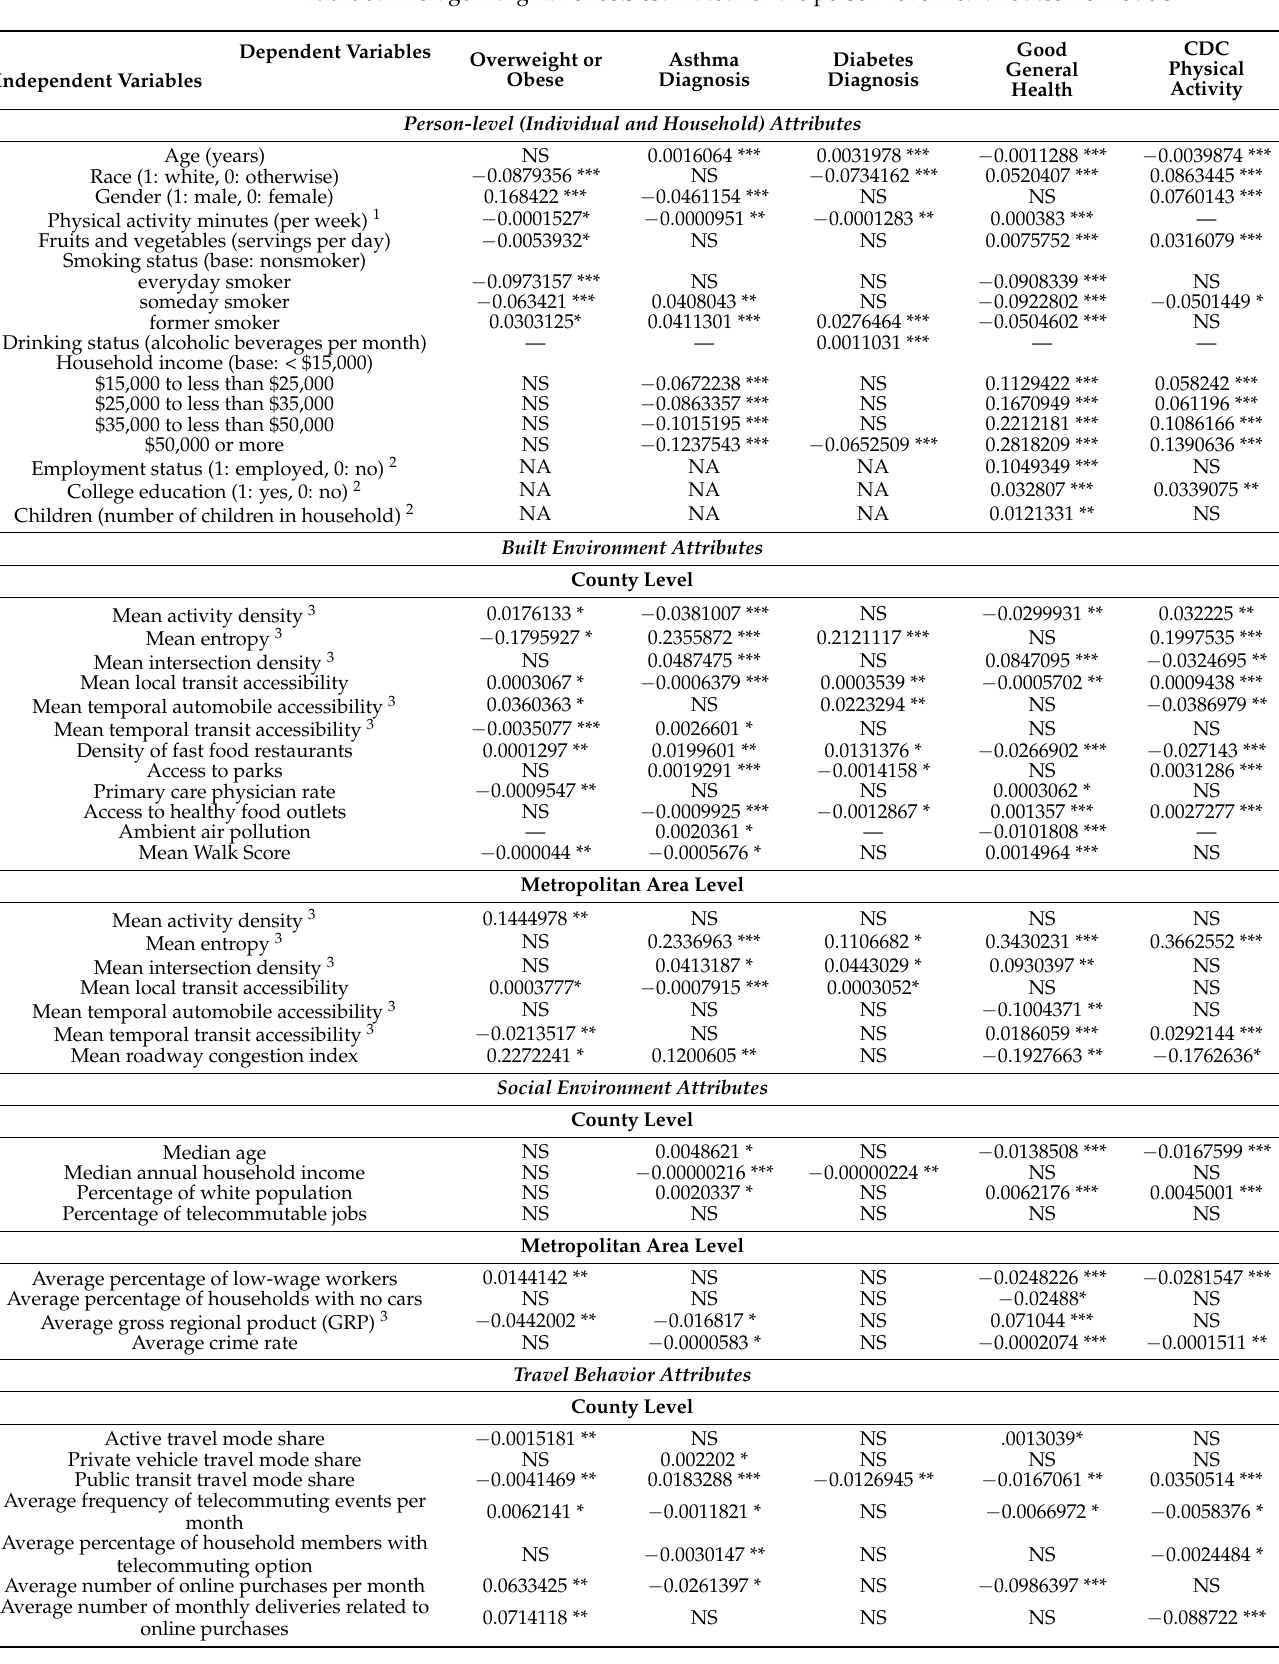
Table 3. Average marginal effects estimated for the person-level health outcome